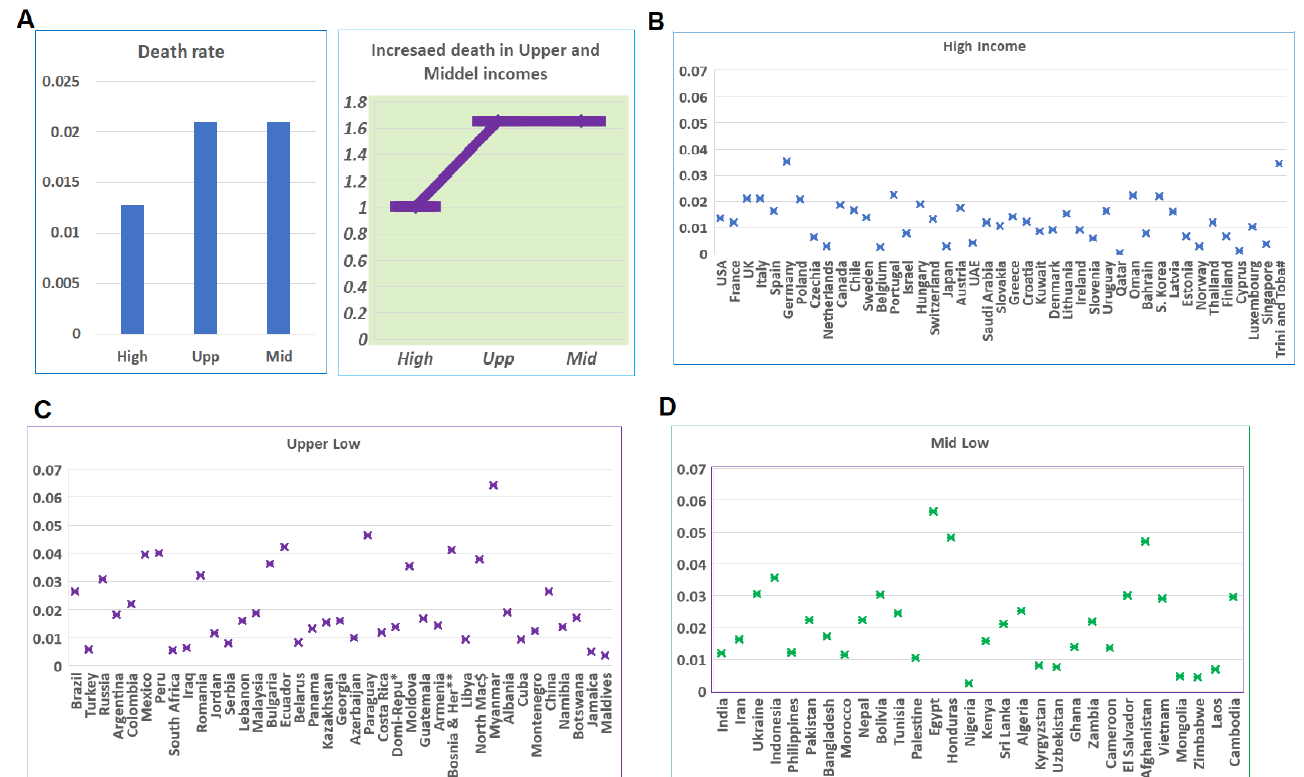
Figure 4. Mortalities in CRs of different income levels at the largest scale of the pandemic. ( A ) Left panel shows the mortality rate in CRs according to income level when COVID-19 reaches the largest scale. Right panel shows the percentages of upper- and lower-middle-income levels in comparison with CRs at a high-income level. ( B ) Distributions of mortalities of CRs at the high-income level. ( C ) Distributions of mortalities of CRs at the upper-middle-income level. ( D ) Distributions of mortalities of CRs at the lower-middle-income level.